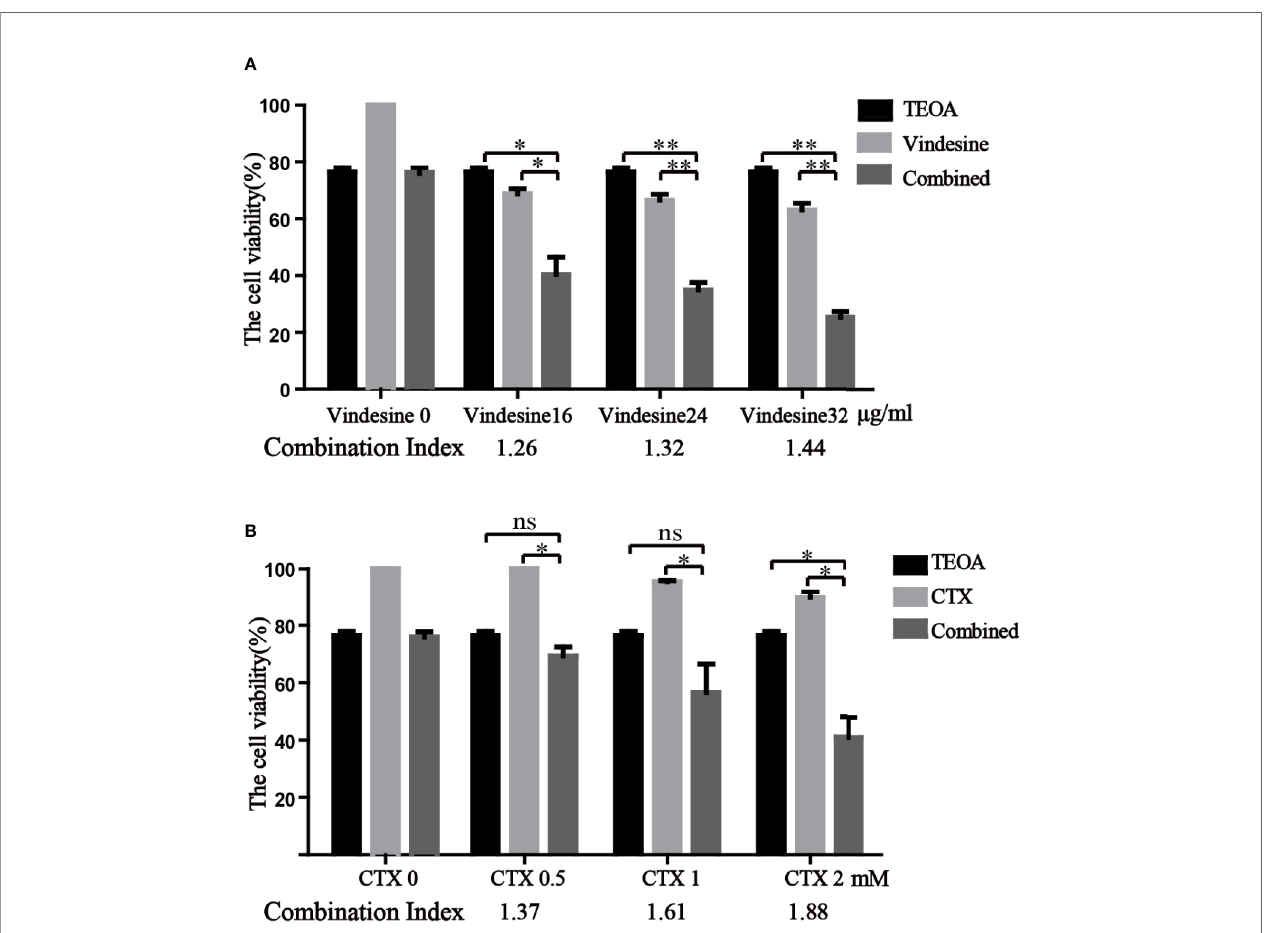
FIGURE 7 | TEOA exhibited a signi fi cant synergistic activity with vindesine or cyclophosphamide in diffuse large B-cell lymphoma (DLBCL) cells. (A, B) The therapeutic effect of TEOA in combination with vindesine or cyclophosphamide was measured by the CCK-8 assay. OCI-LY10 cells were treated with 15 µM TEOA with or without different concentrations of vindesine or cyclophosphamide for 12 h. And the combination index was calculated below. * P <0.05, ** P <0.01, ns= no signi fi